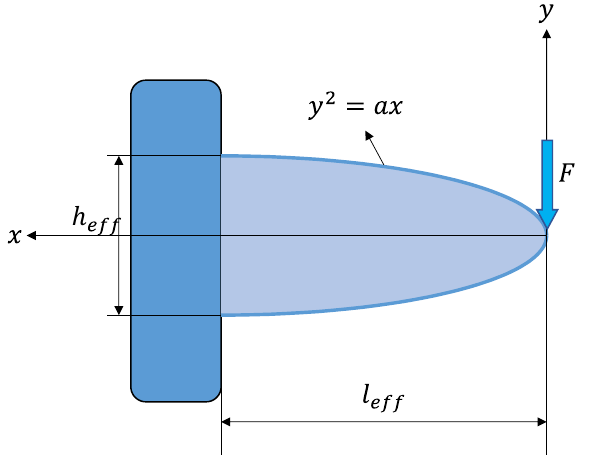
Figure 9. Cantilever beam with a parabolic